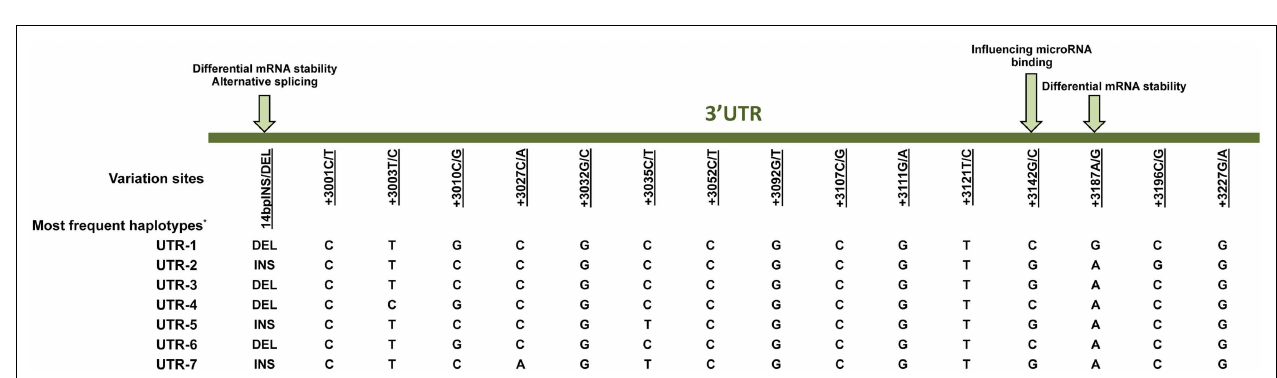
indicate polymorphic sites that have been functionally studied. *Since there is no official nomenclature for 3 (cid:48) UTR haplotypes, they were designed as previously reported (11). DEL, deletion; INS,